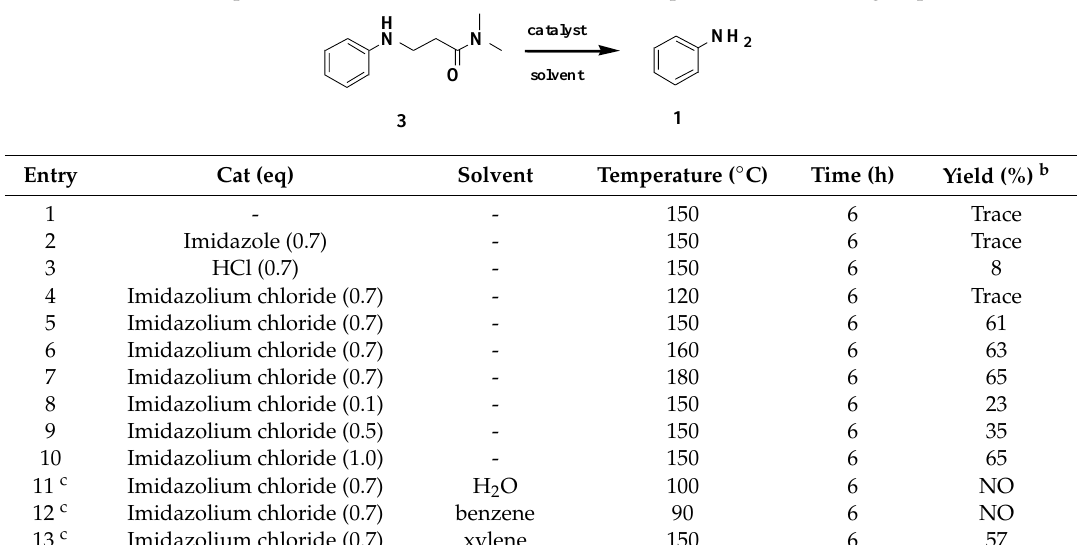
Table 2. Optimization of reaction conditions for the deprotection of amino group a .